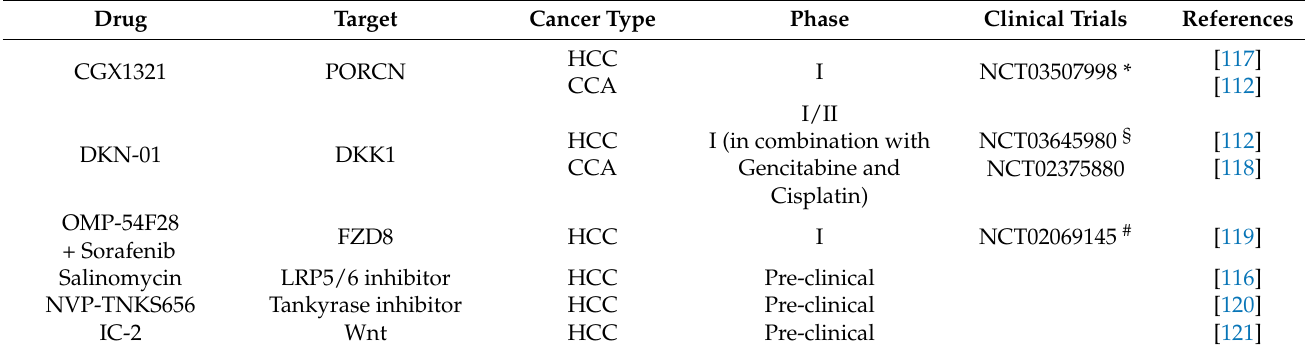
Table 1. Wnt/ β -catenin inhibitors in clinical and pre-clinical trials for human HCC and